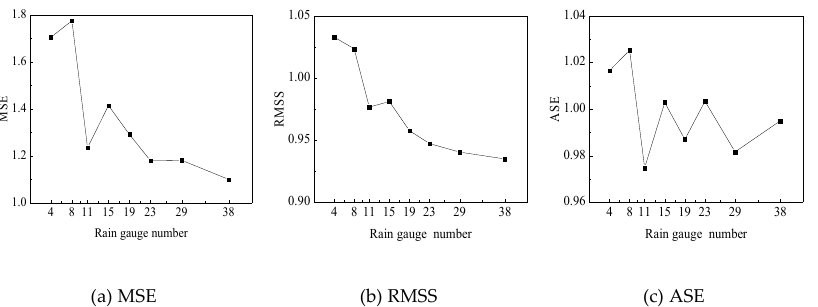
Figure 3. Three cross-validation statistics of MSE ( a ), RMSS ( b ) and ASE ( c ) under different rain gauge numbers combination.